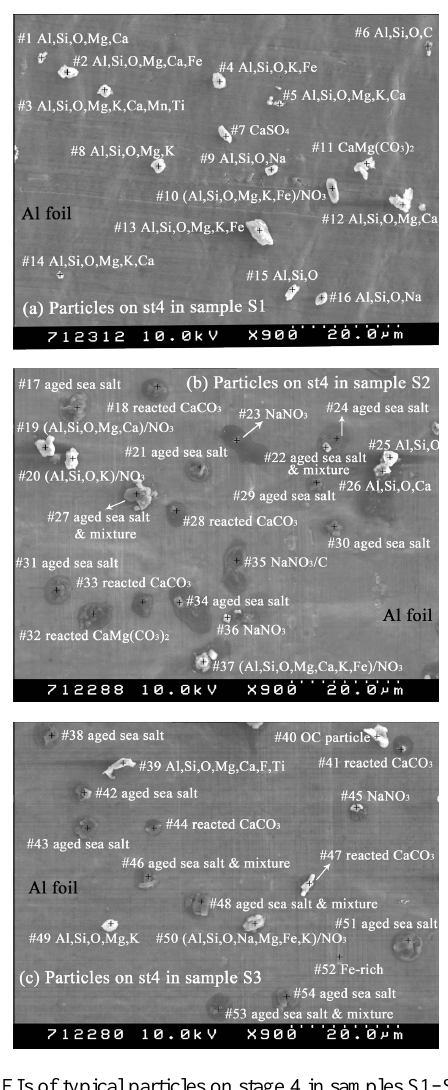
Fig. 6. SEIs of typical particles on stage 4 in samples S1–S3.